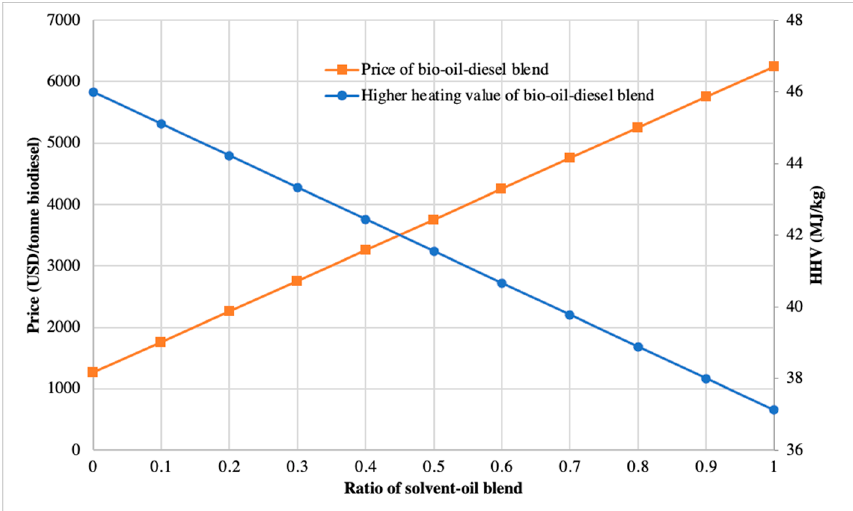
Figure 3. The relationship between the price, HHV and ratio of the biodiesel blend.